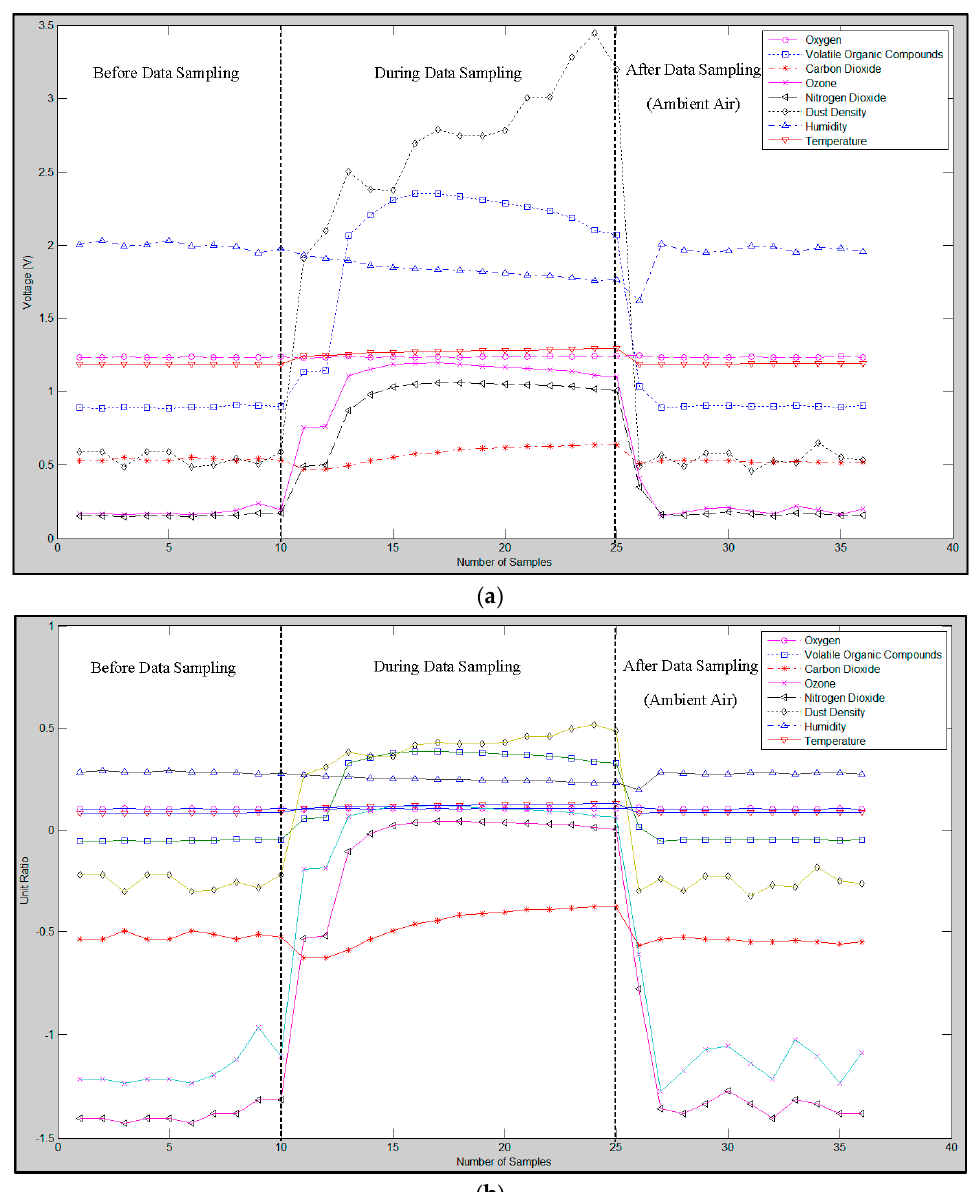
Figure 2. ( a ) Example of raw data for a scorching smell generated by paper at 250 °C; ( b ) The RLSSV feature extracted from the scorching smell of paper at 250 °C in (a).